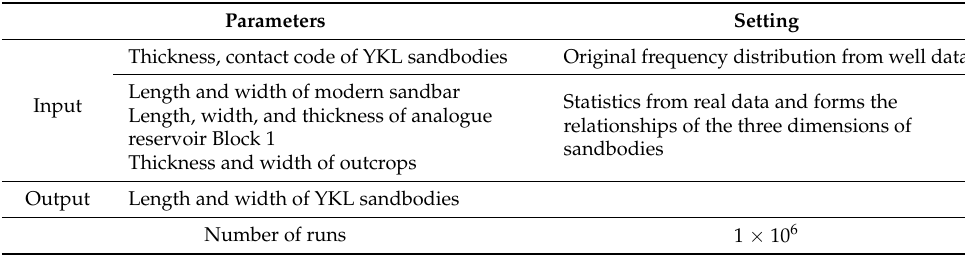
Table 4. Settings of the Monte Carlo